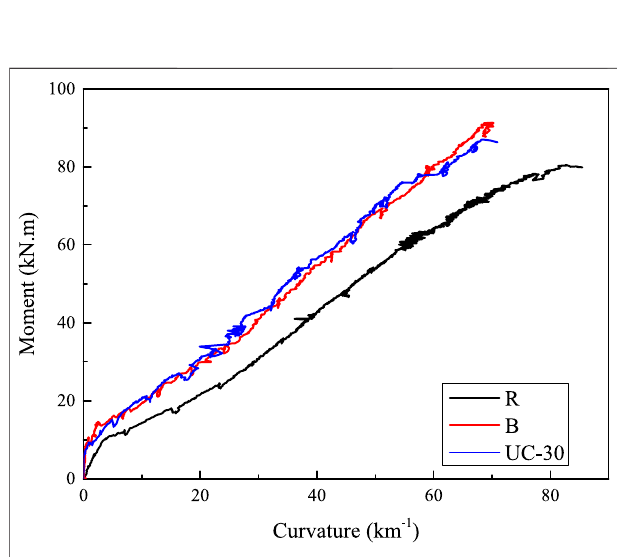
FIGURE 7 | Load versus strain curves of GFRP bars and CFRP grids (taken from beam UC-30).